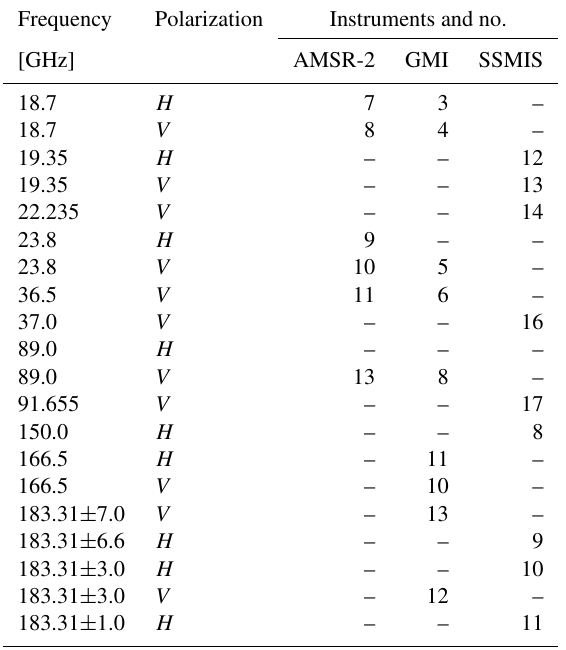
at high frequencies, i.e., 166.5 GHz, offering unique Table 2. Channel characteristics of the Advanced Microwave Scan- ning Radiometer-2 (AMSR-2), Global Precipitation Mission mi- crowave imager (GMI), and the Special Sensor Microwave Im- ager/Sounder (SSMIS) considered in this study. Instruments and no.